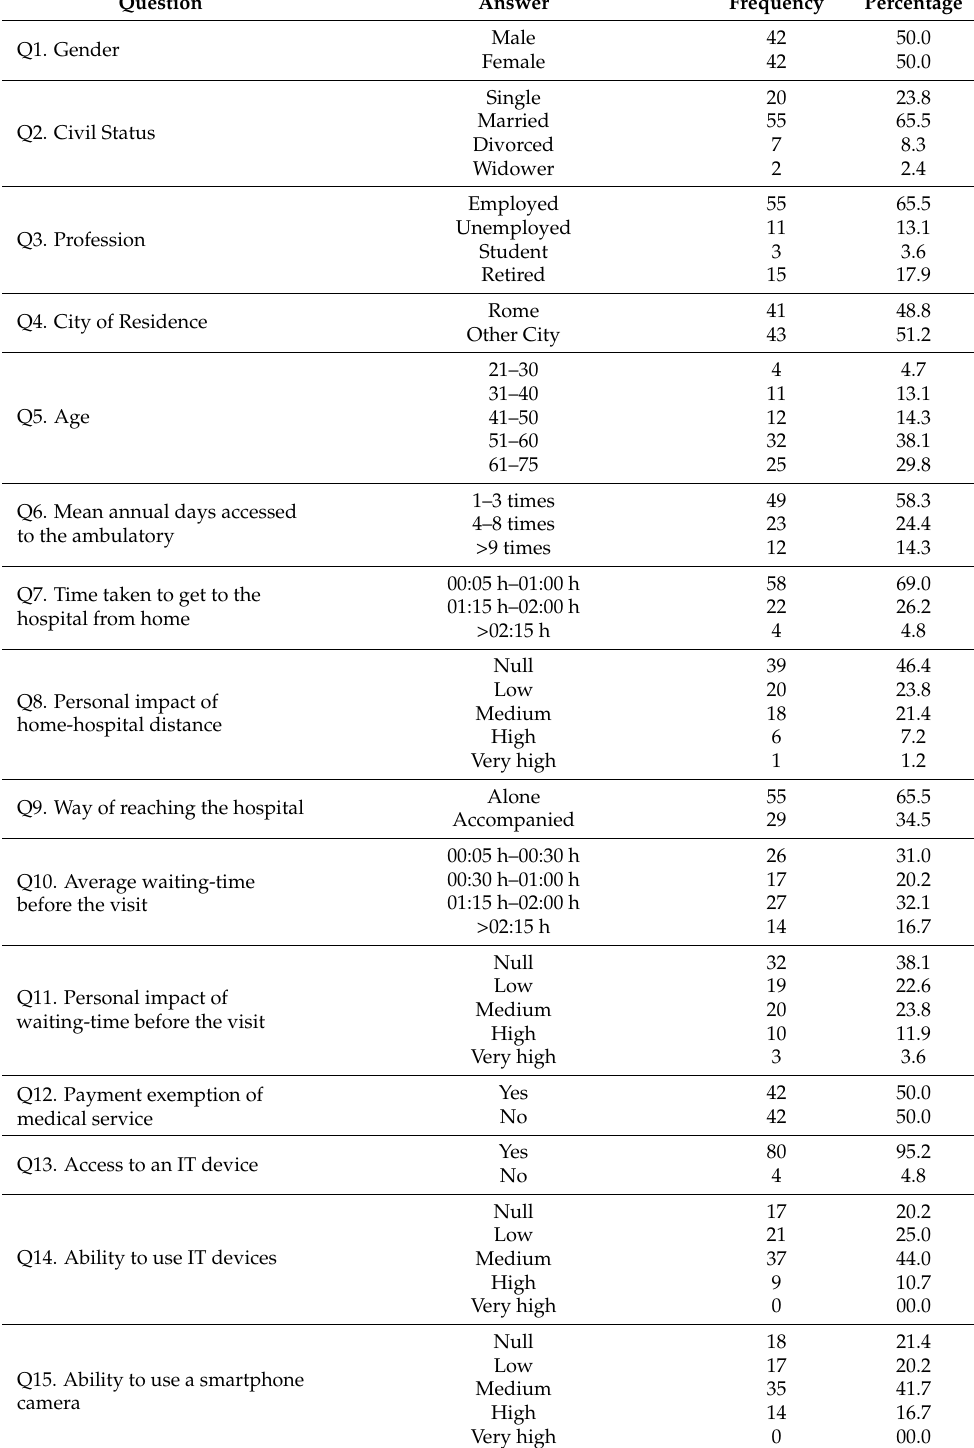
Table 1. Frequencies and percentages of answers to our